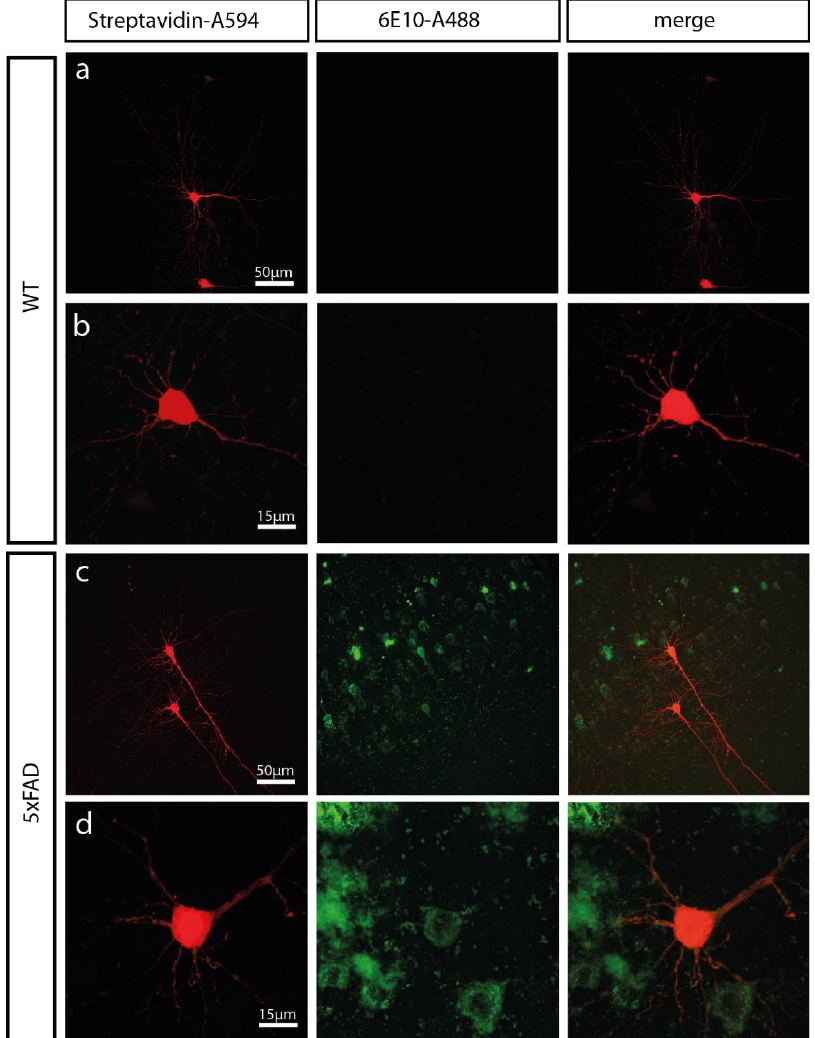
Figure 1. The somatosensory cortex of 6-months-old 5xFAD mice displays abundant amyloid beta ( Aβ ) load. Low ( a + c ) and high-magnification ( b + d ) confocal images of biocytin-filled pyramidal cells in the somatosensory cortex of a 6-months-old 5xFAD mouse and wildtype (WT) mouse. Biocytin-filled neurons were detected by fluorescently labelled streptavidin (Streptavidin-A594; left panel). Aβ protein was detected with the 6E10 antibody coupled to A488 (6E10-A488; middle panel). Merges of both channels are shown in the right panel.